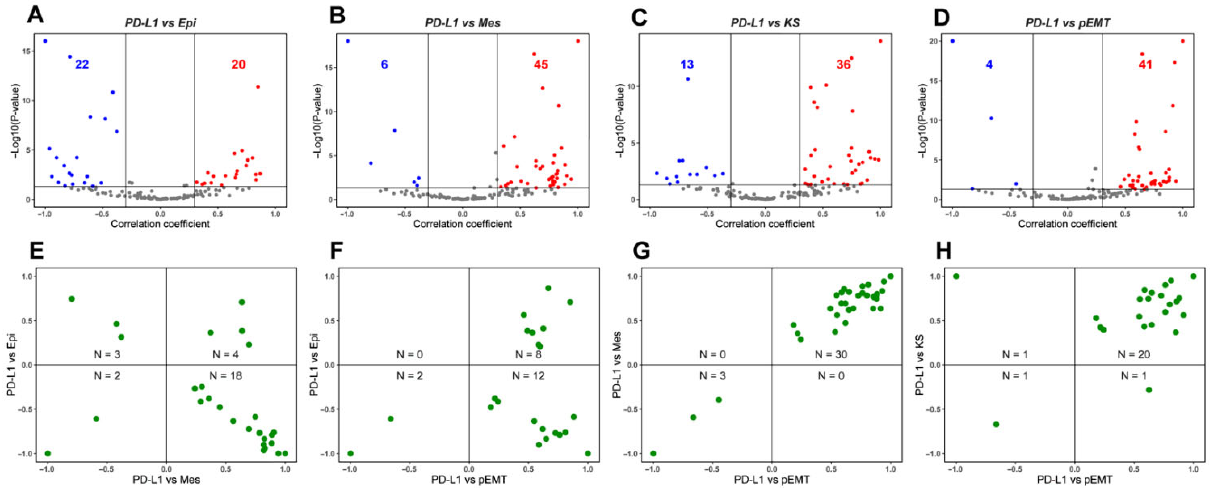
Figure 1. Association between PD ‐ L1 activity gene signature and partial ‐ EMT. ( A ) Volcano plots showing the correlation coefficient, R (x ‐ axis), and ‐ log 10 ( p ‐ value) (y ‐ axis) for PD ‐ L1 vs. Epi scores. Boundaries for significant correlation are set at |R| > 0.3 and p < 0.05. Same as ( A ) but for ( B ) PD ‐ L1 vs. Mes, ( C ) PD ‐ L1 vs. KS and ( D ) PD ‐ L1 vs. pEMT scores. ( E ) Two ‐ dimensional scatter plot depicting the correlation coefficient ‘R’ between PD ‐ L1 vs. Mes (x ‐ axis) and PD ‐ L1 vs. Epi scores (y ‐ axis). ‘N’ denotes the number of significant data points lying in each quadrant. Same as ( E ) but for ( F ) PD ‐ L1 vs. pEMT and PD ‐ L1 vs. Epi, ( G ) PD ‐ L1 vs. pEMT and PD ‐ L1 vs. Mes and ( H ) PD ‐ L1 vs. pEMT and PD ‐ L1 vs. KS scores. Each dot denotes a dataset for which this correlation is calculated.